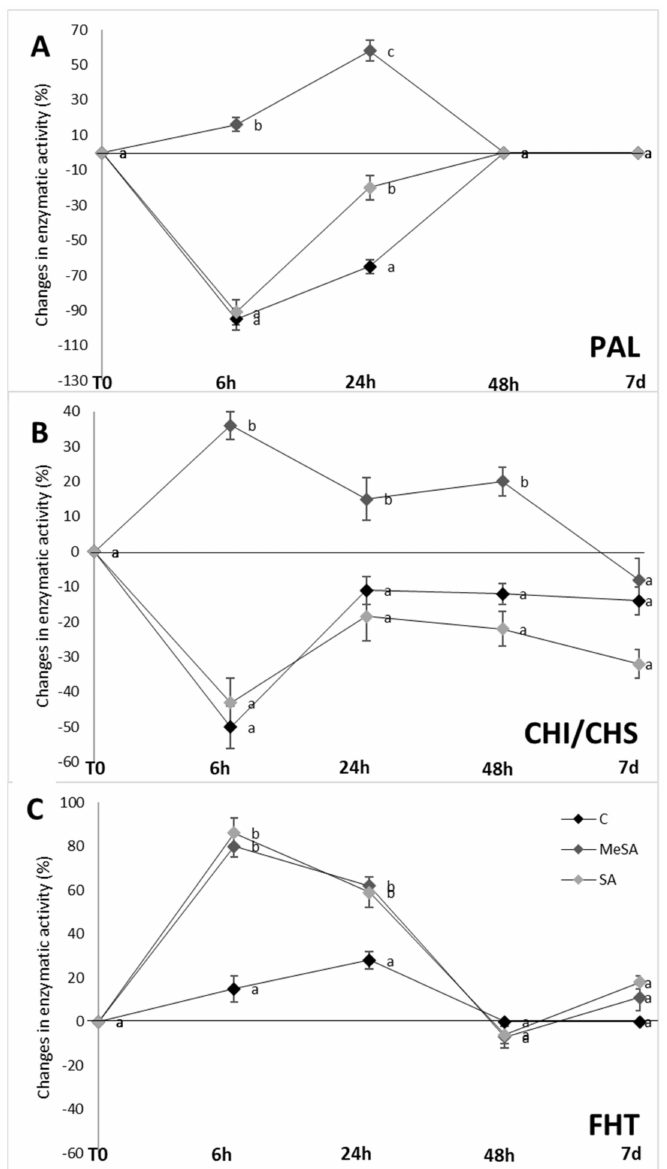
Figure 5. Specific enzyme activities in fruit peel for phenylalanine ammonia-lyase ( A ); (PAL), combined chalcone synthase (CHS) and chalcone isomerase (CHI) ( B ) and flavanone-3 β -hydroxylase ( C ); (FHT) following control ( C ), methyl salicylic acid (MeSA) and salicylic acid (SA) treatments of apple trees, for the different sampling times after the first spraying (Spray#1). Data are means of calculated values ± standard error ( n = 10). Different letters indicate significant difference between treatments at each sampling time ( p < 0.05; Duncan